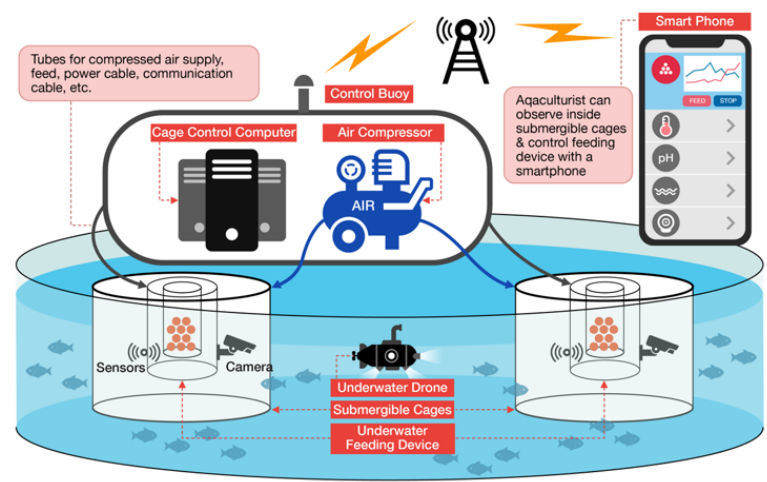
Figure 1. Concept diagram of smart aquaculture